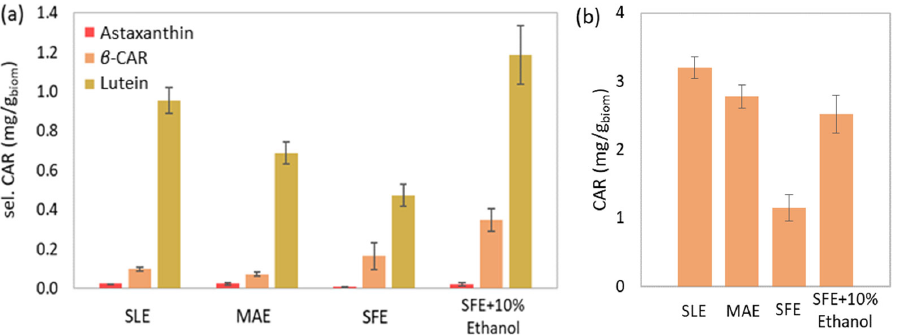
Figure 8. Comparison between the conventional solid ‐ liquid extraction (SLE), microwave ‐ assisted extraction (MAE), supercritical fluid extraction (SFE) and supercritical fluid extraction with 10% w / w cosolvent addition (SFE + 10% Ethanol) of Chlorella vulgaris , regarding the ( a ) selected and ( b ) total carotenoid content expressed in amount of bioactive component per amount of biomass.